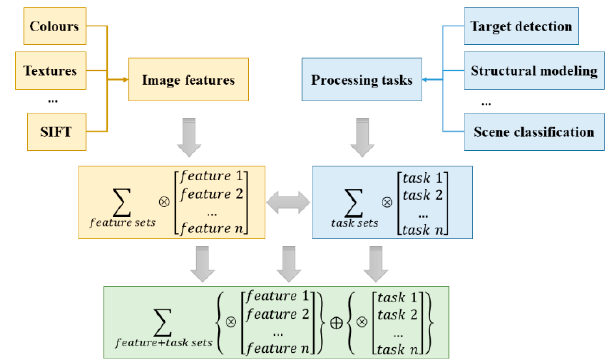
Figure 8. System engineering framework for geographic scene understanding based on HSR remote sensing image.